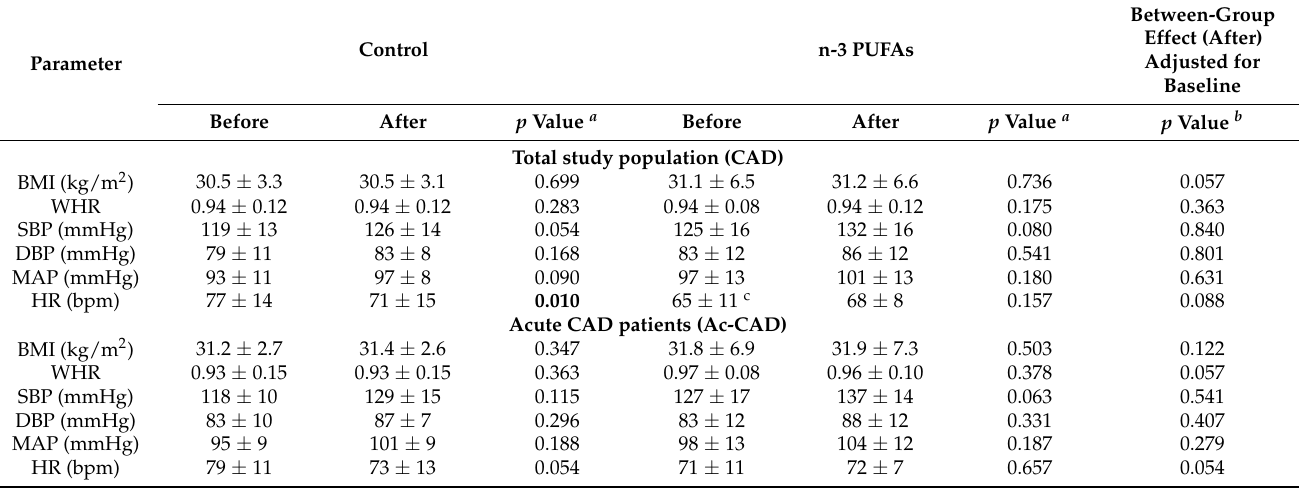
Figure 1. Flowchart of participants through each stage of the study. CAD—coronary artery disease; Ac-CAD—acute coronary artery disease; Ch-CAD—chronic coronary artery disease. Table 2. The effect of regular (control group) and n-3 PUFA-enriched hen eggs (n-3 PUFAs group) consumption on anthropometric and hemodynamic parameters in the total study population (CAD) and in the two subgroups of patients (Ac-CAD patients and Ch-CAD